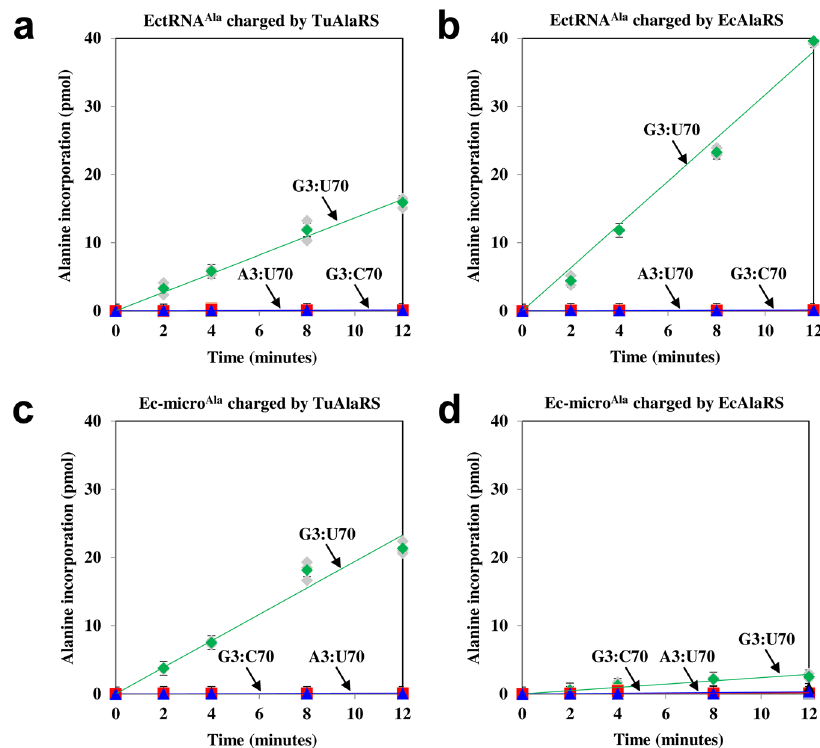
Fig. 2 Aminoacylation assay. The aminoacylation activities of ( a ) TuAlaRS and ( b ) EcAlaRS toward WT and mutant EctRNA Ala transcripts were determined by testing their ability to incorporate 3 H-alanine into the transcripts. The aminoacylation activities of ( c ) TuAlaRS and ( d ) EcAlaRS toward WT and mutant Ec-micro Ala transcripts were determined under similar conditions. The enzyme concentration used in the reactions was 100 nM. Error bars are standard deviation from